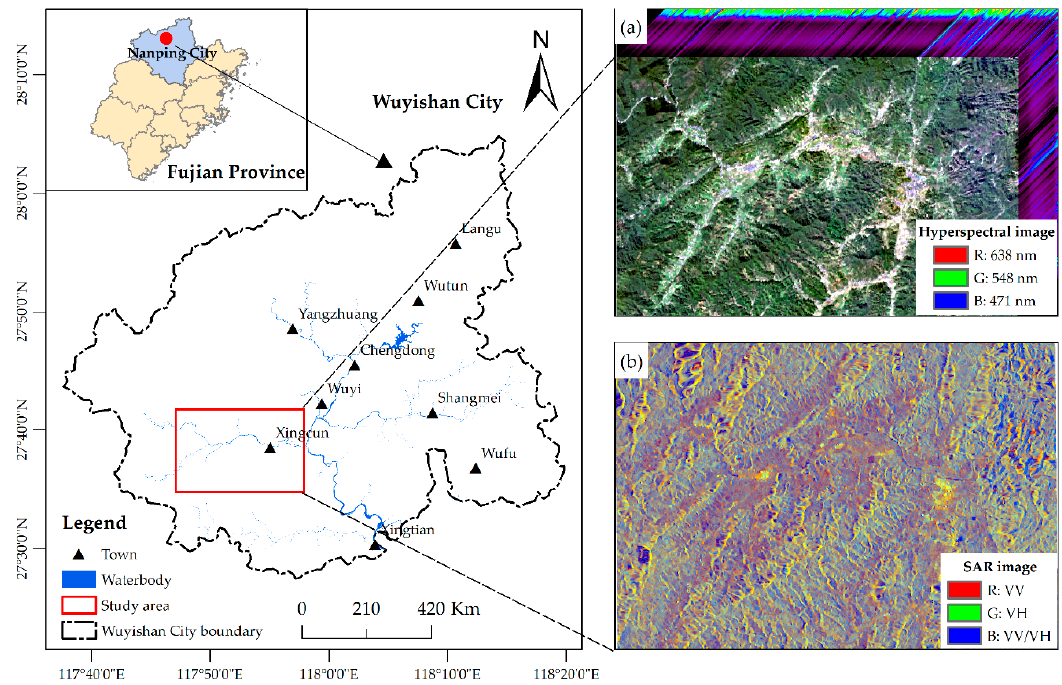
Figure 1. Location of Wuyishan City, Nanping City, Fujian Province, China, and the location of the study area: ( a ) the hyperspectral image (from Chinese Gaofen-5 satellite) and ( b ) the Synthetic Aperture Radar (SAR) image (from Sentinel-1A satellite) of the study area.